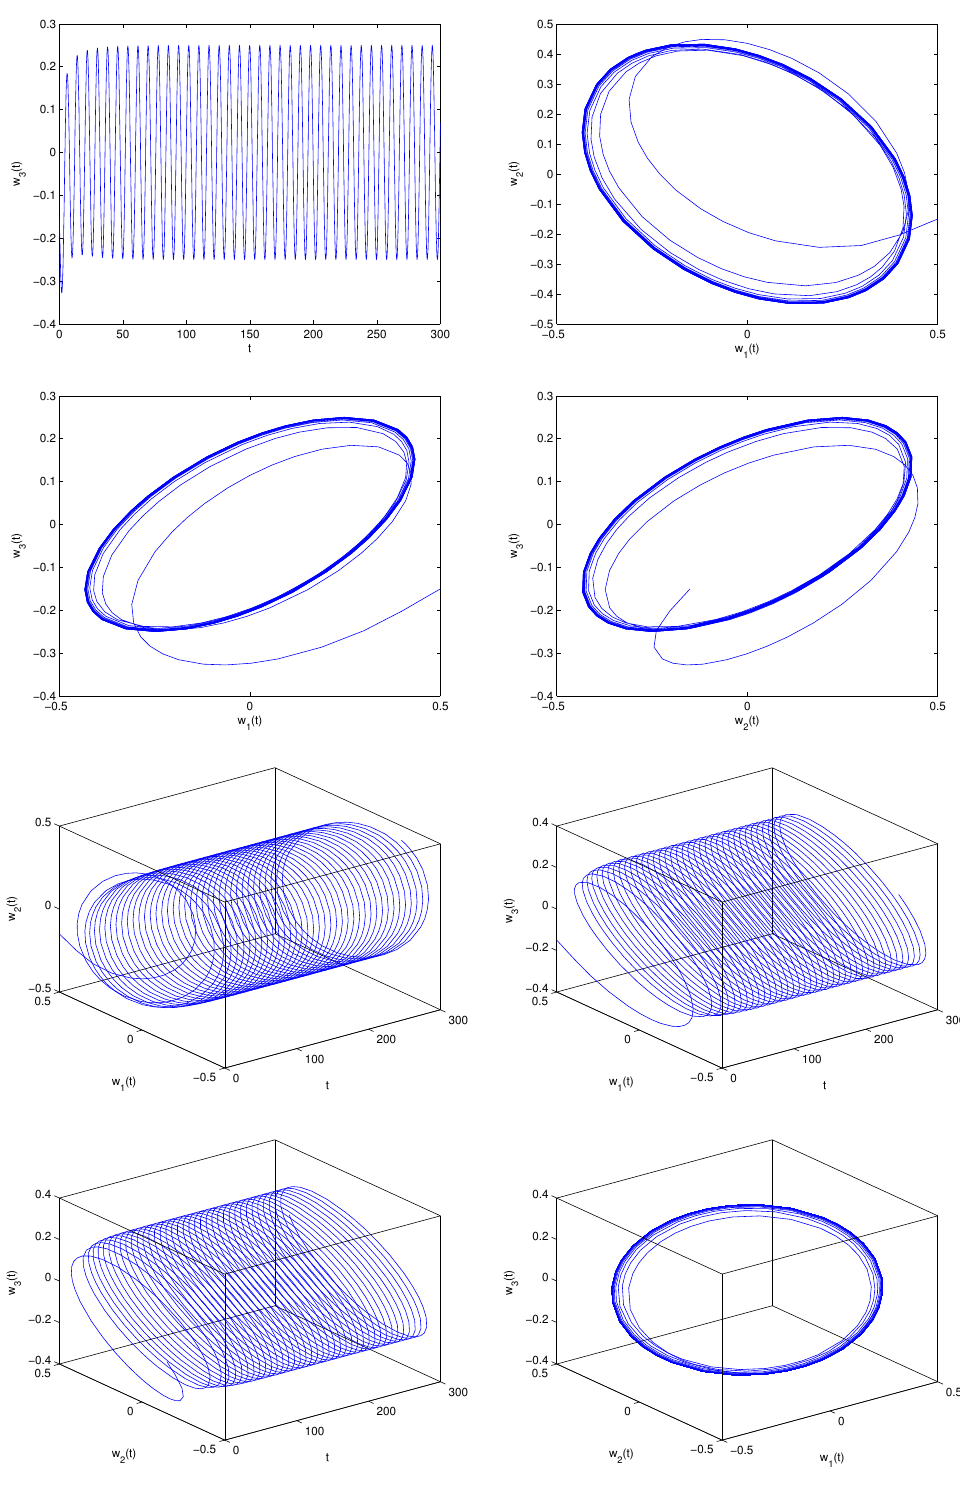
Figure 7. Computer simulation figures of system (96) with ρ = 0.35 > ρ (cid:63) ≈ 0.3. The Hopf bifurcation arises in the vicinity of W 0 ( 0,0,0 ) when time t → ∞